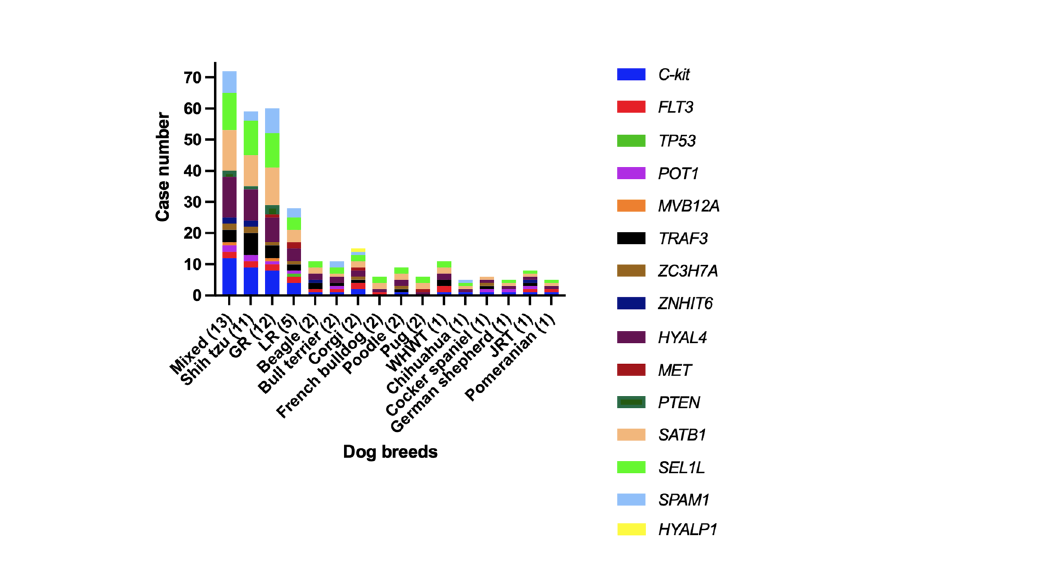
Figure 1. The bar chart shows the incidence of single nucleotide polymorphisms observed in each dog